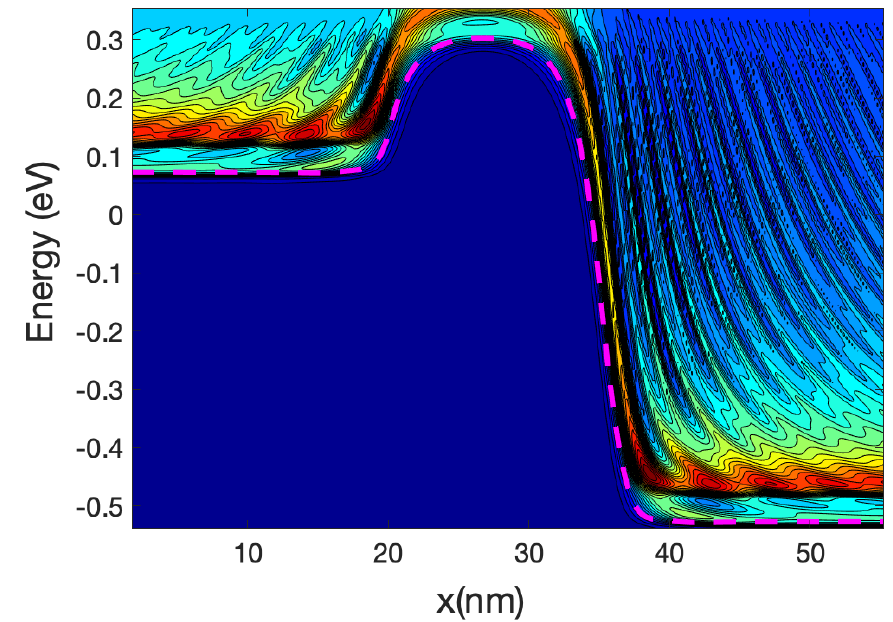
Figure 2. Schematics of a wrap-round gate silicon nanowire field-effect transistor of length 55 nm cut away to expose the channel region. The oxide thickness is 0.8 nm and the channel width is 2.2 nm. The channel length (gate length) is 15 nm, the source and drain extensions are 20 nm. The work function of the metal gate is 4.5 eV. The projected image shows a typical non-equillibrium Green function (NEGF)-computed local density of states (LDOS) for the device assuming a drain bias of 0.6V and a gate bias at 0.6 V. The location of the first 1D sub-band edge is shown along the central nanowire x-axis as a function of energy and position (dashed white line); it mimics the self-consistent potential along the same axis. In the projected image, the vertical energy scale is from − 0.6 eV to 0.23 eV.